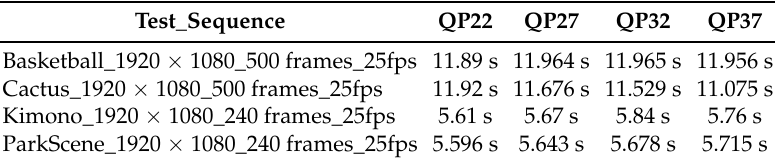
Table 3. JCT-VC 2D test sequences—common transcoding